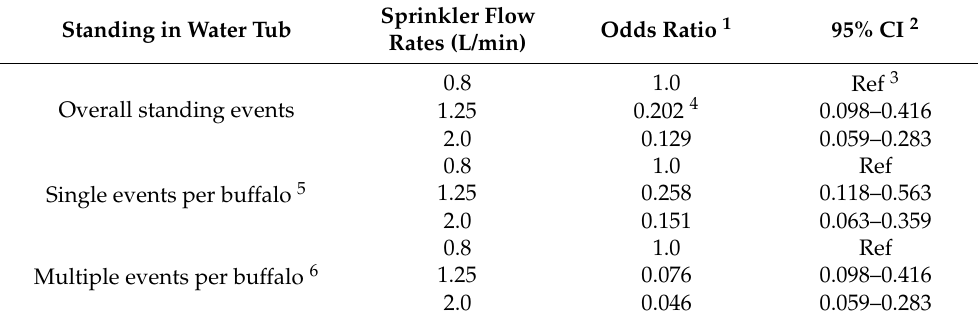
Table 6. Association of sprinkler flow rate with the standing in water tubs behavior of Nili Ravi buffaloes ( n = 18). Sprinkler Flow Standing in Water Tub Odds Ratio 1 95% CI Rates (L/min)